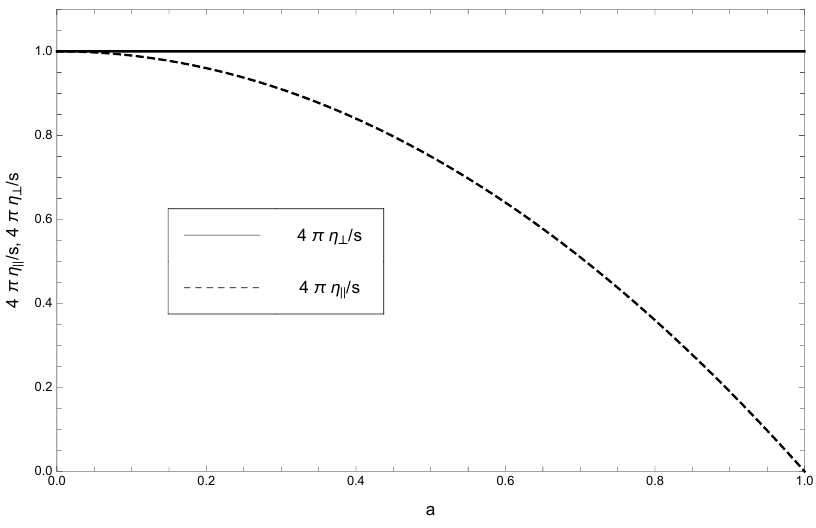
=s and (cid:17) ? =s jj